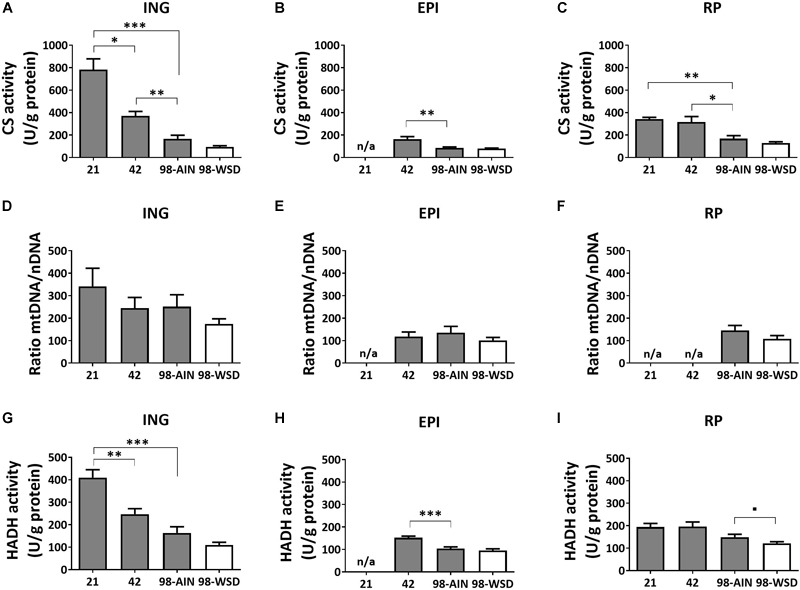
Changes in mitochondrial content markers, citrate synthase (CS), mtDNA and hydroxyacyl-Coenzyme A dehydrogenase (HADH), between PN21 and PN98. CS activity in (A) ING WAT, (B) EPI WAT, (C) RP WAT; mtDNA copy number in (D) ING WAT, (E) EPI WAT, (F) RP WAT; HADH activity in (G) ING WAT, (H) EPI WAT, and (I) RP WAT. PN, postnatal day; AIN, AIM93-M diet; WSD, western style diet. Data expressed as mean + SEM, n = 8 for PN 21 and PN42 and n = 11 for PN98, no data available (n/a) for EPI WAT at PN21 and for RP WAT at PN21 and PN42 for mtDNA copy number. Time and WSD effects were analyzed separately; time effect: ∗p < 0.05; ∗∗p < 0.01; ∗∗∗p < 0.001; WSD effect: ■0.05 < p < 0.1.